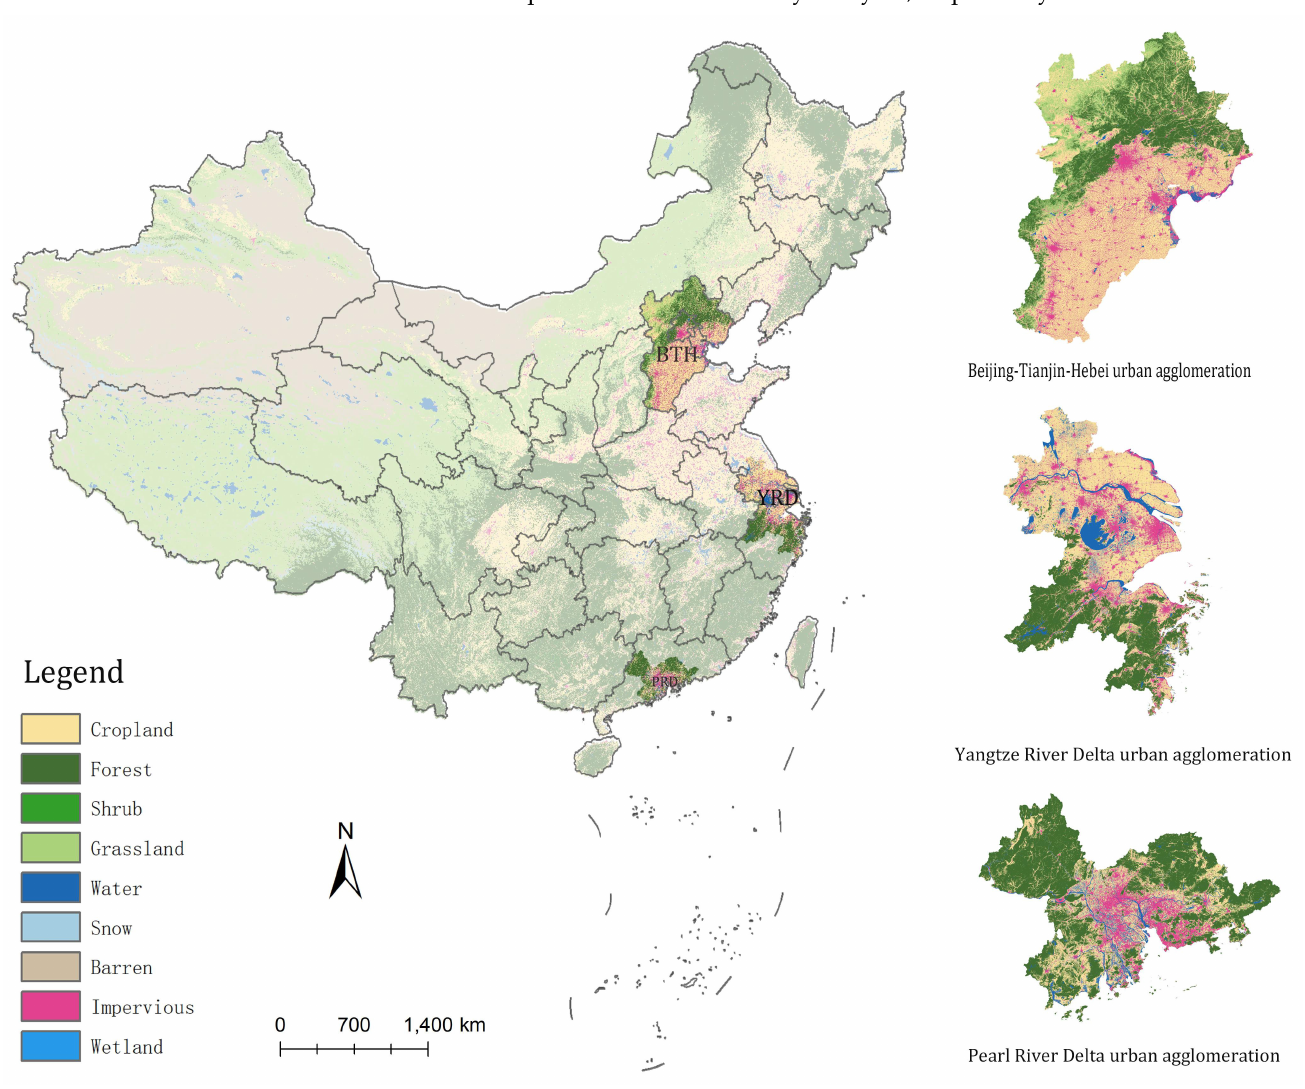
Figure 1. The location and LUCC map of the three major UAs in